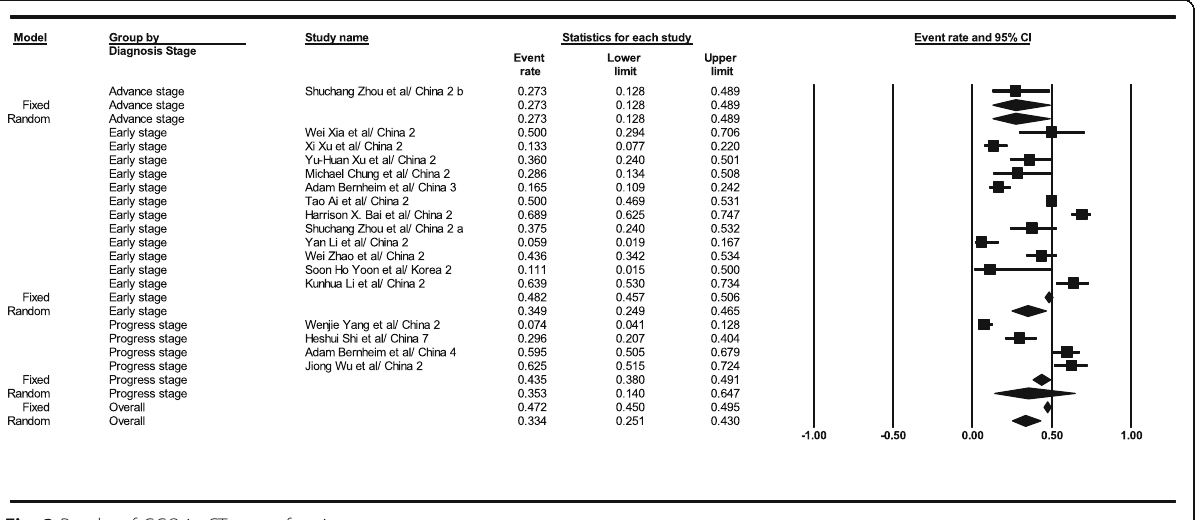
Fig. 3 Results of GGO in CT scan of